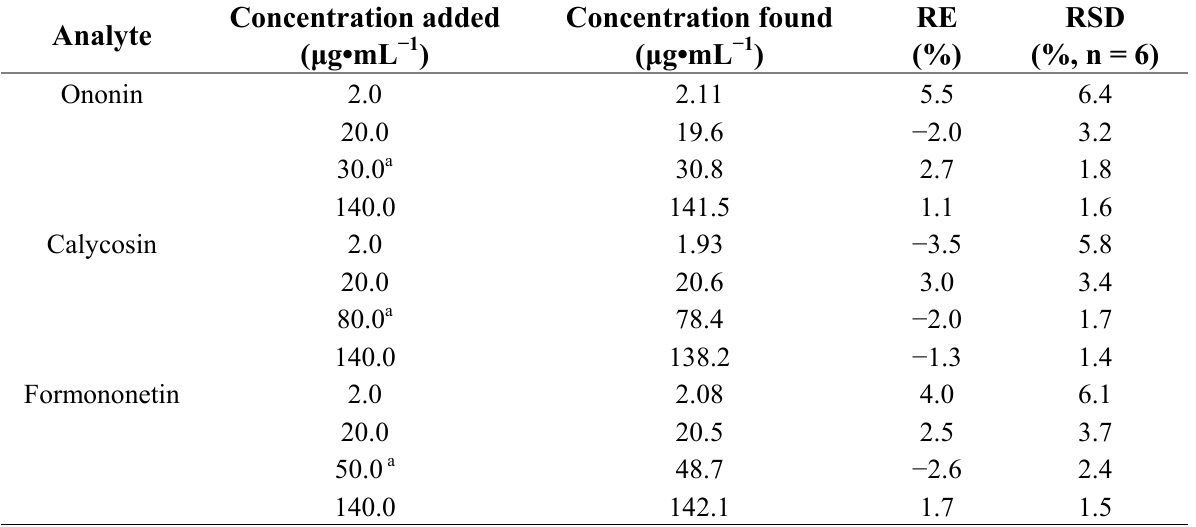
Table 3. Summary of precision and accuracy of ononin, calycosin and formononetin.